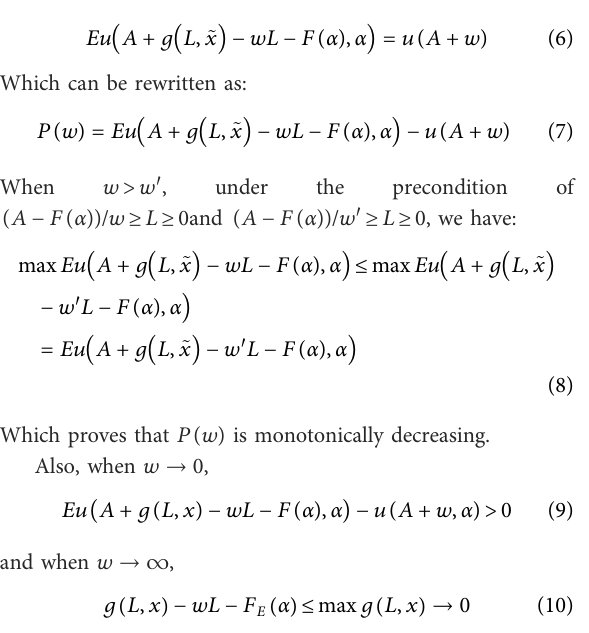
FIGURE 1 Wages under the equilibrium of